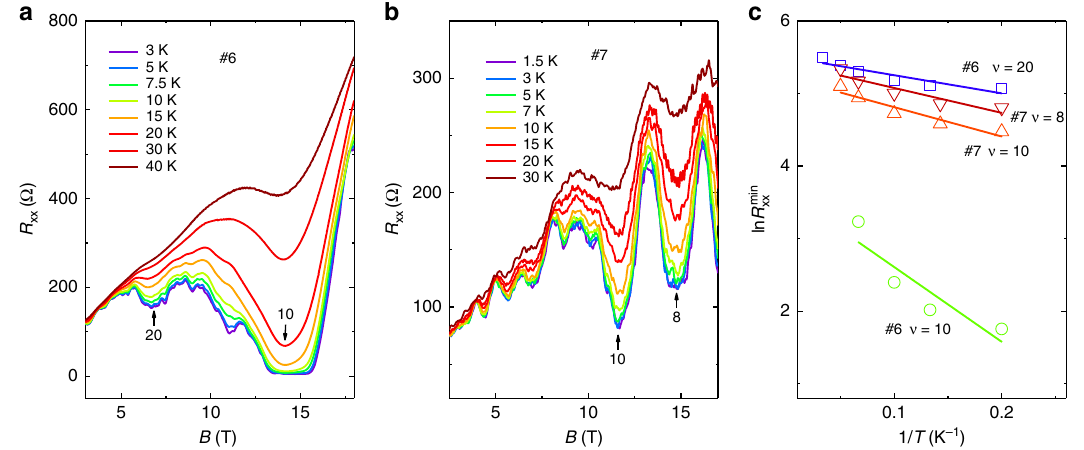
Fig. 4 Temperature dependence of R xx in Cd 3 As 2 nanoplate. a , b Longitudinal magnetoresistance R xx at different temperatures in sample #6 a and #7 b . c The Arrhenius plots of the resistance minima for each Landau level to extract the activation energy through linear fi